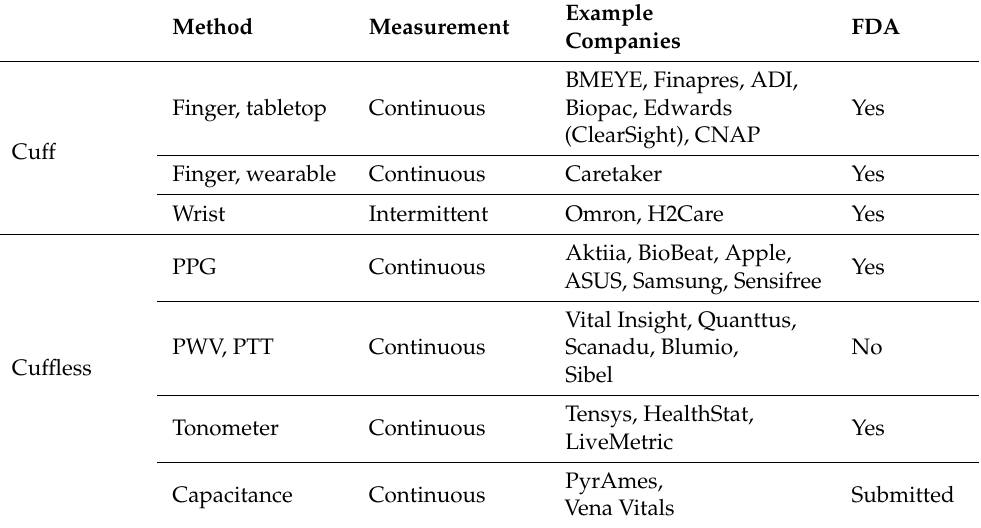
Table 1. Methods for determining BP. Adapted * from Ref.